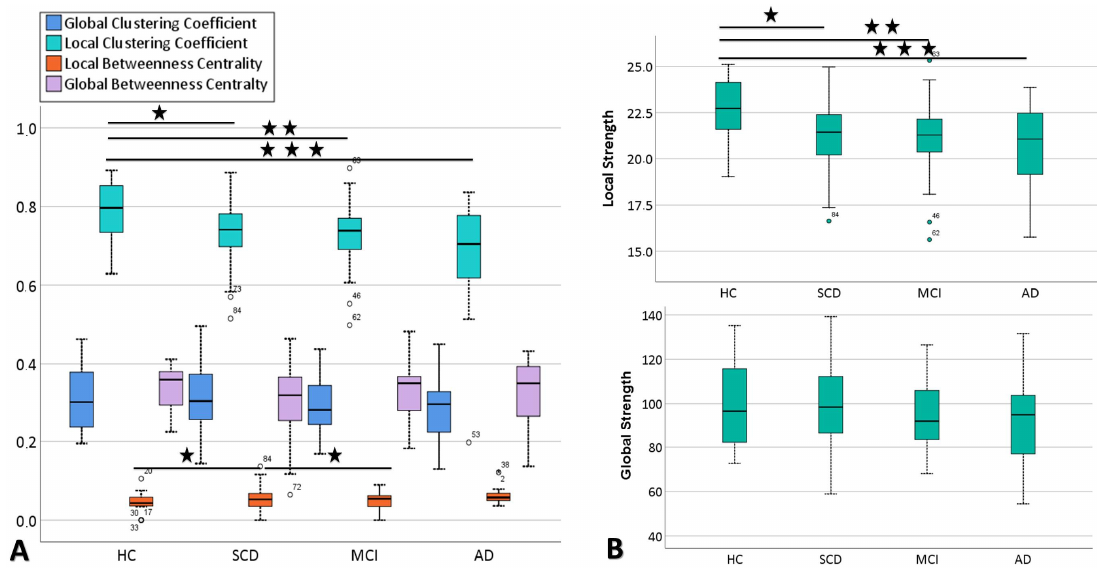
Figure 3. Boxplots showing differences in global and local network metrics for the separate groups of participants (HC = 22, SCD = 20, MCI = 30, AD = 20) in ( A ) clustering coefficient and betweenness centrality and ( B ) strength.